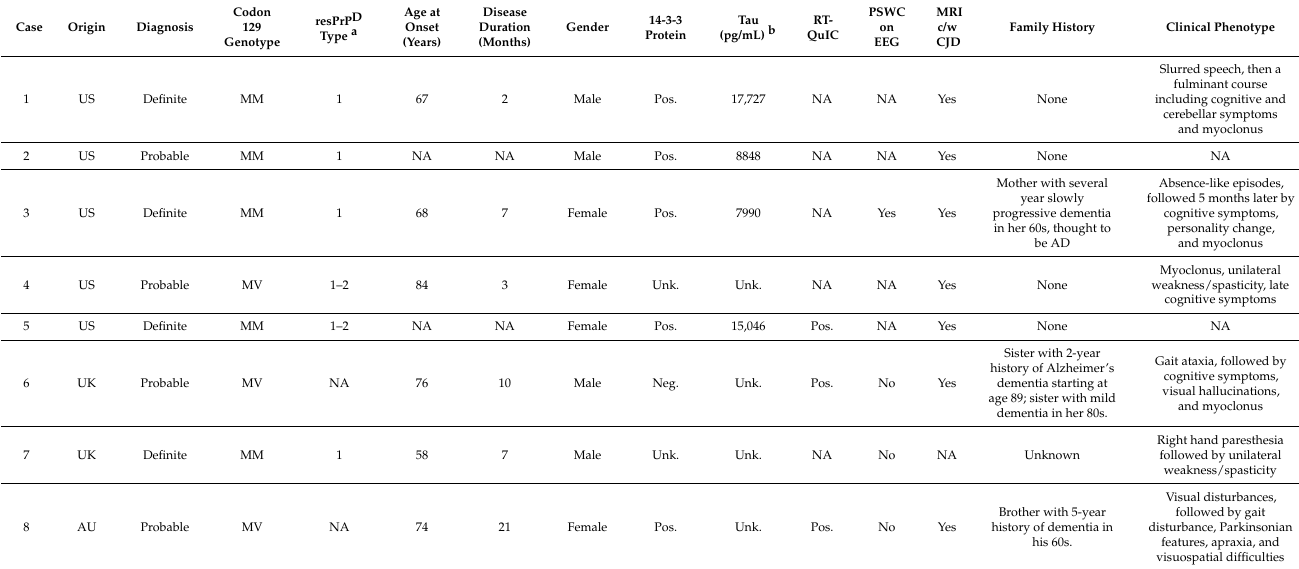
Table 1. Clinical presentation of 2-OPRI cases.